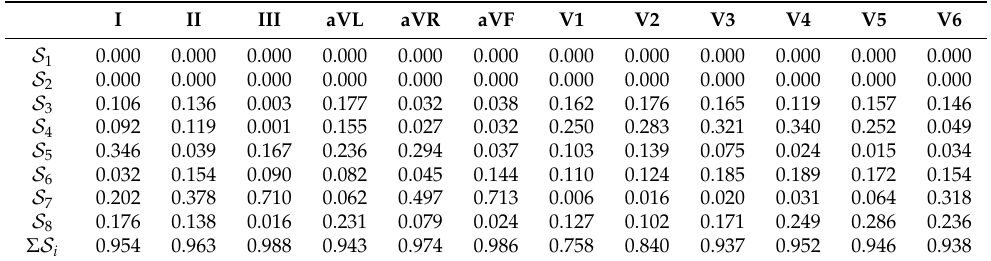
Table 2. First order, PCE-based Sobol indices. The time-dependent indices were integrated over the complete signal length and are depicted here for all 12 leads and input parameter addressed (P1